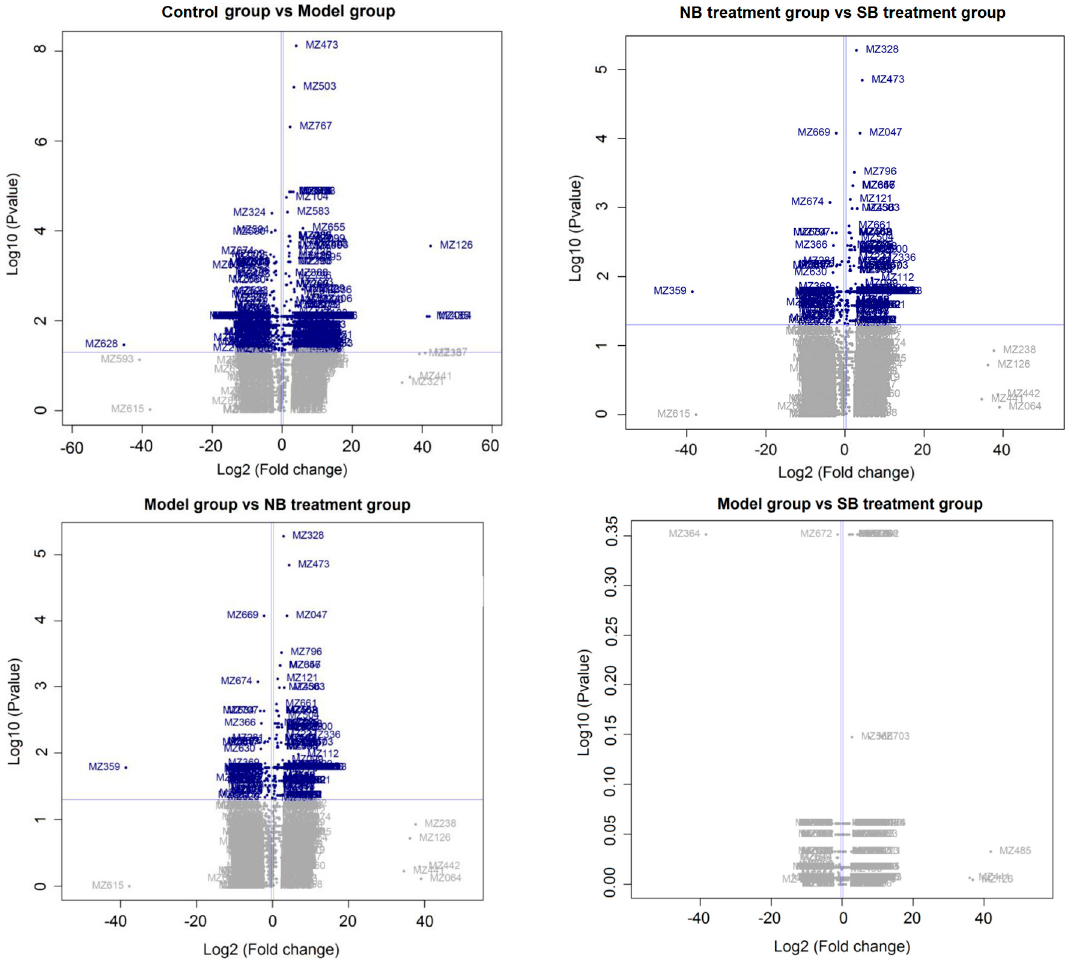
Figure 6. Volcano plot results of identical biomarkers in various groups. Blue variables represent significant results ( p value < 0.05) and showed fold changes >1.2 or <0.8.